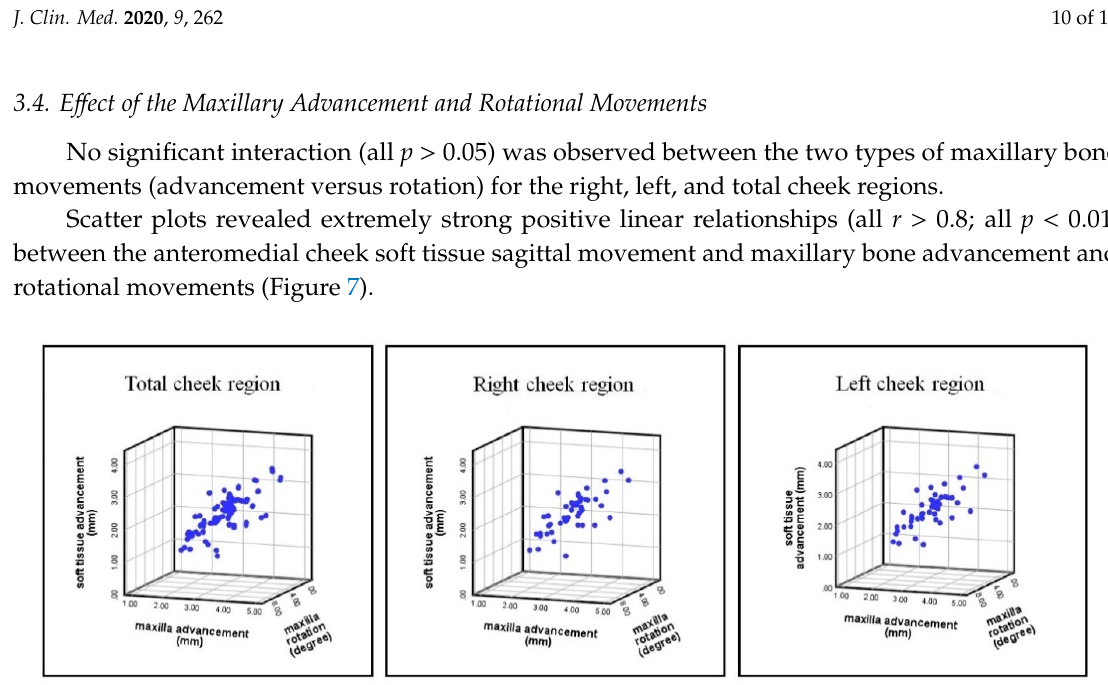
Figure 7. Scatter plots of correlation between the anteromedial cheek soft tissue region movement (mm) and the Le Fort I maxillary advancement (mm) and rotational (degrees) movements, with r = 0.892, r = 0.889, and r = 0.890 for the right, left, and total cheek regions (all p < 0.01). Multiple linear regression analyses revealed a significant effect of the maxillary advancement (all p ≤ 0.001) and maxillary rotation (all p ≤ 0.006) on the anteromedial cheek soft tissue sagittal movement. Overall, 79% of the variation in the anteromedial cheek soft tissue sagittal movement was